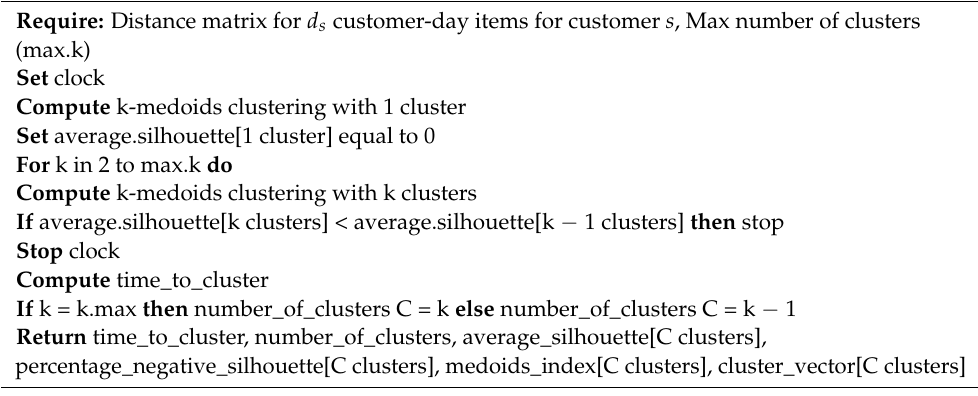
Algorithm A2 k-Medoid Clustering with Automatic Stop Criterion for Single